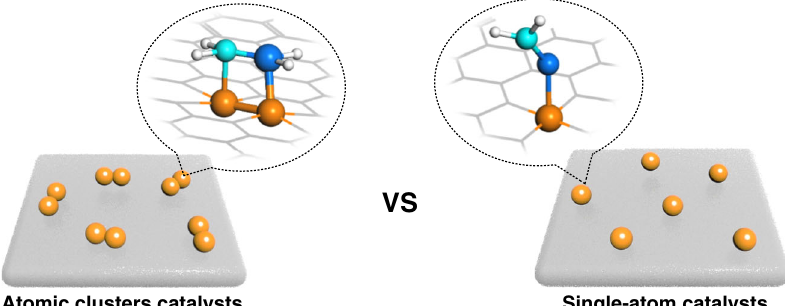
Fig. 1 Comparison diagram of adsorption modes in catalysis. Schematic view and corresponding structure model of the supported atomic clusters catalysts (left) and the single-atom catalysts